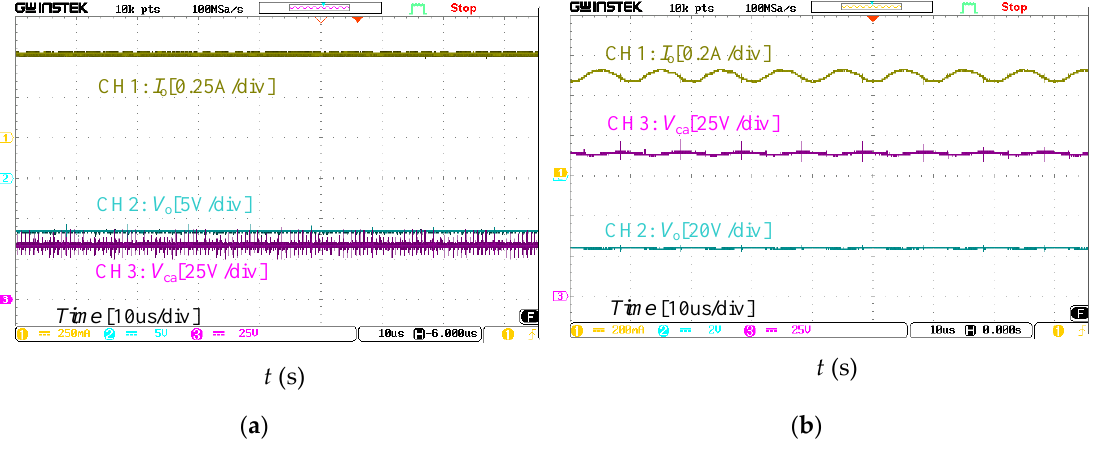
Figure 13. Steady-state waveforms of I o , V o , and V ca under different loads. ( a ) Output load with 2 LEDs in series; ( b ) output load with 12 LEDs in series.